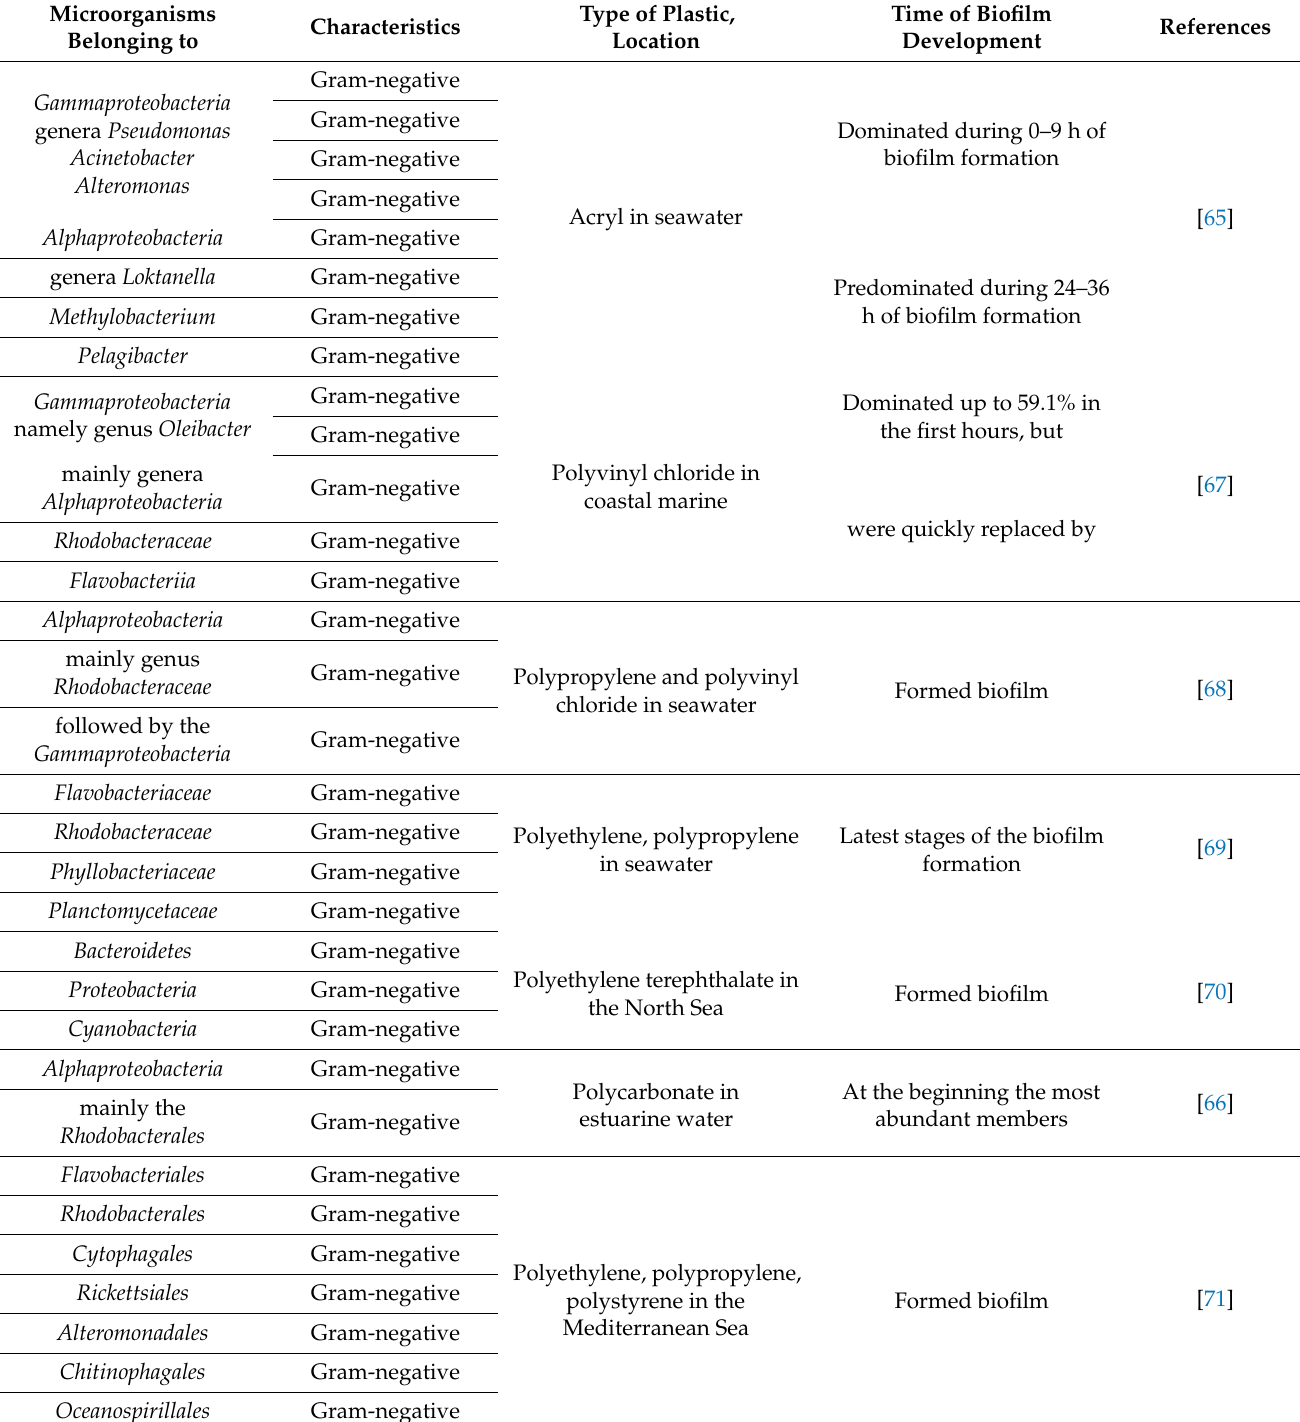
Table 1. Dominated microorganisms in biofilms on microplastics found in salinity